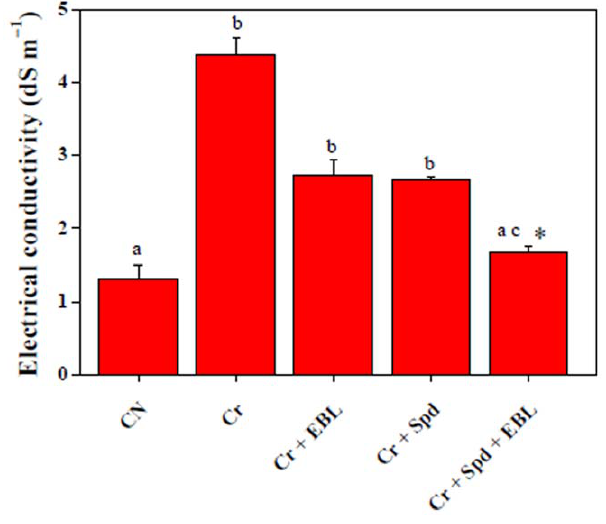
Figure 7. Ion leakage (dS m 2 1 ) of 7-d-old radish seedlings under Cr-stress without or with EBL and /or Spd. Data are presented as mean 6 SE. Different superscripted letters (a, b, c) indicate significant difference from each other in all combinations (Tukey’s test, p , 0.05). Asterisk ‘‘*’’indicates significant difference for EBL + Spd vs. EBL under Cr-stress (Tukey’s test, p ,